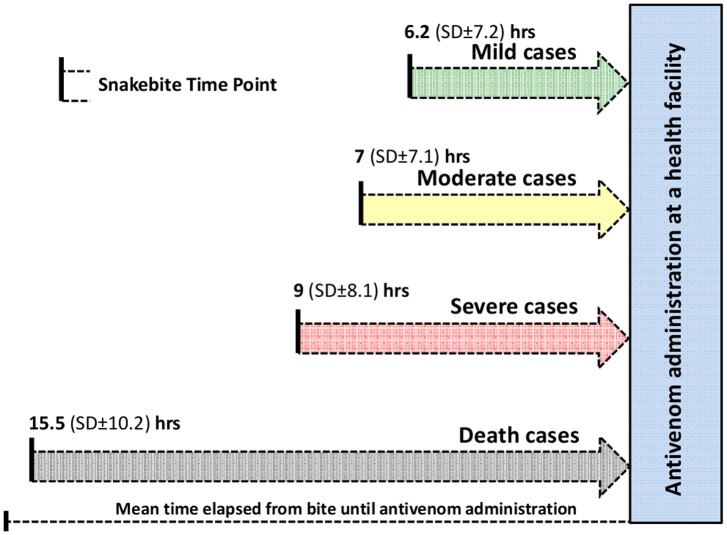
Time elapsed from bite to medical attention at a health facility according to severity grading.Average time directly associated to severity grading, with a longer time observed for cases evolving to death.